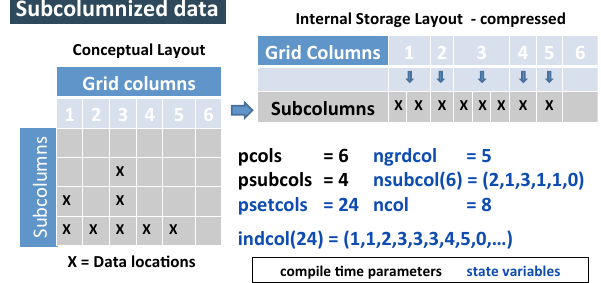
Figure A1. Schematic for CAM’s subcolumn software framework. The number of subcolumns varies by grid column, as shown in the conceptual layout (left). Internally, the subcolumns are stored in a compressed layout (right). The information on per-chunk linkages is stored in a series of software parameters, some of which can be set by the user (black) and others of which are internally calcu- lated (blue). pcols is the maximum number of grid columns, psub- cols is the maximum number of subcolumns, psetcols is the max- imum number of all columns (i.e., pcols · psubcols ), ngrdcol is the actual number of grid columns that contain data, nsubcol(pcols) is the number of subcolumns in each grid column with data, ncol is the total number of all subcolumns with data, and indcol(psetcols) is the grid index for each subcolumn that is used for mapping subcolumns back to grid